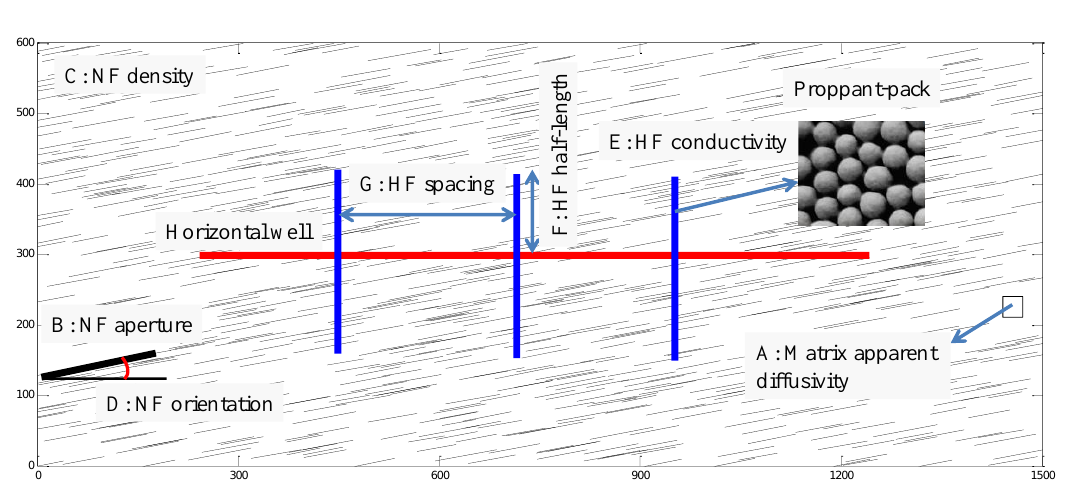
Figure 1. Numerical model of multi-stage hydraulically fractured shale reservoir horizontal well. Table 1. Optimization parameter in this study.